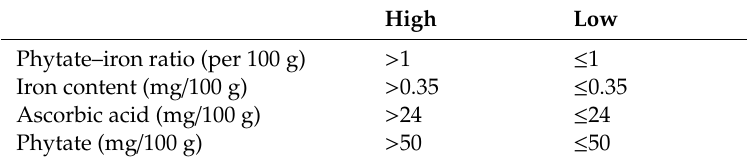
Table 1. Categorization of nutrient density for food pattern modeling by nutrients of